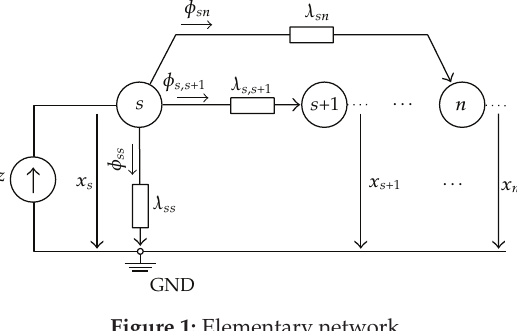
Figure 1: Elementary